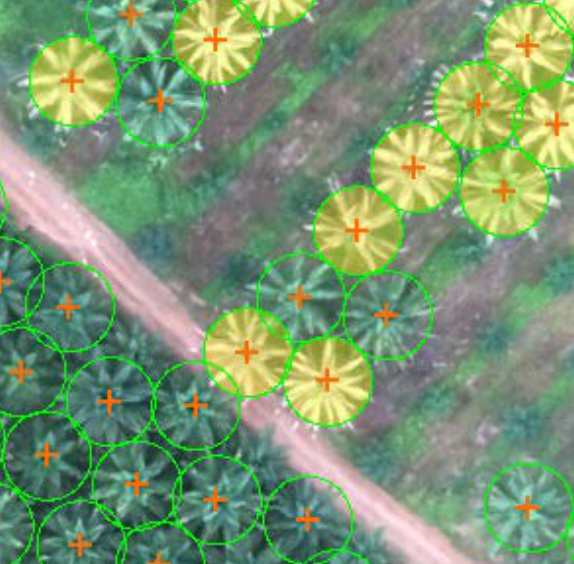
Figure 7: Tree health analysis (unhealthy trees in yellow). Tree crown delineation represented by green circles.